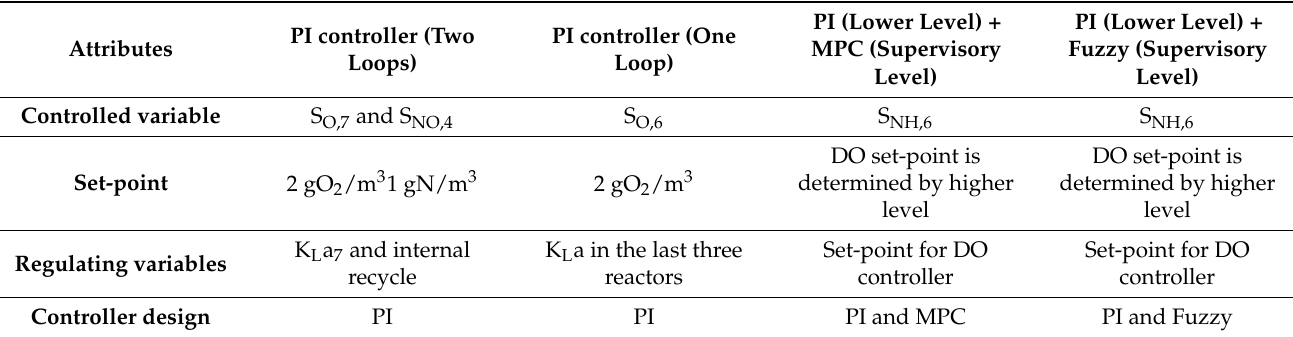
Figure 3. Control frameworks for BSM2-P: ( A ) PI controllers, ( B ) Lower level control, ( C ) Supervisory level control framework with a lower level. Table 4. Functioning of control